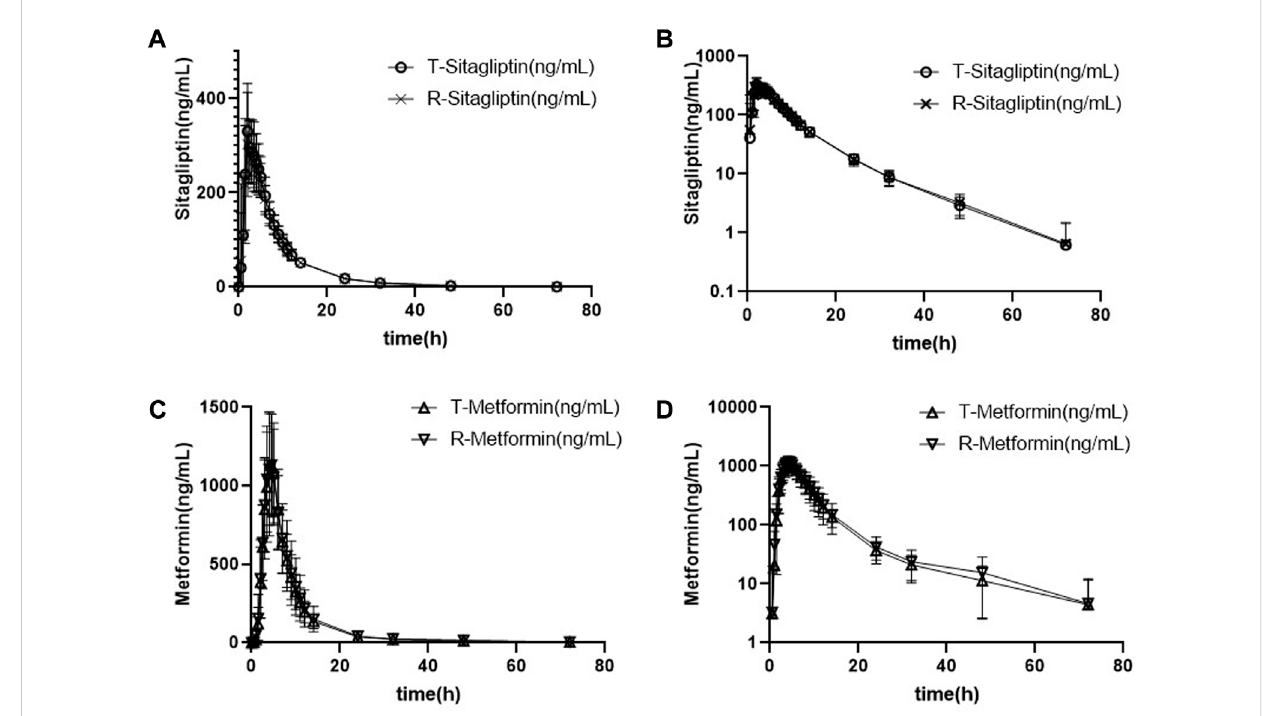
FIGURE 2 Meanplasmasitagliptinandmetforminconcentration-timepro fi lesafterdosingunderthefastingstate.Errorbarsrepresentthestandarddeviations. (A) Sitagliptin, linear scale, (B) sitagliptin, semi-log scale, (C) metformin, linear scale, and (D) metformin, semi-log scale.